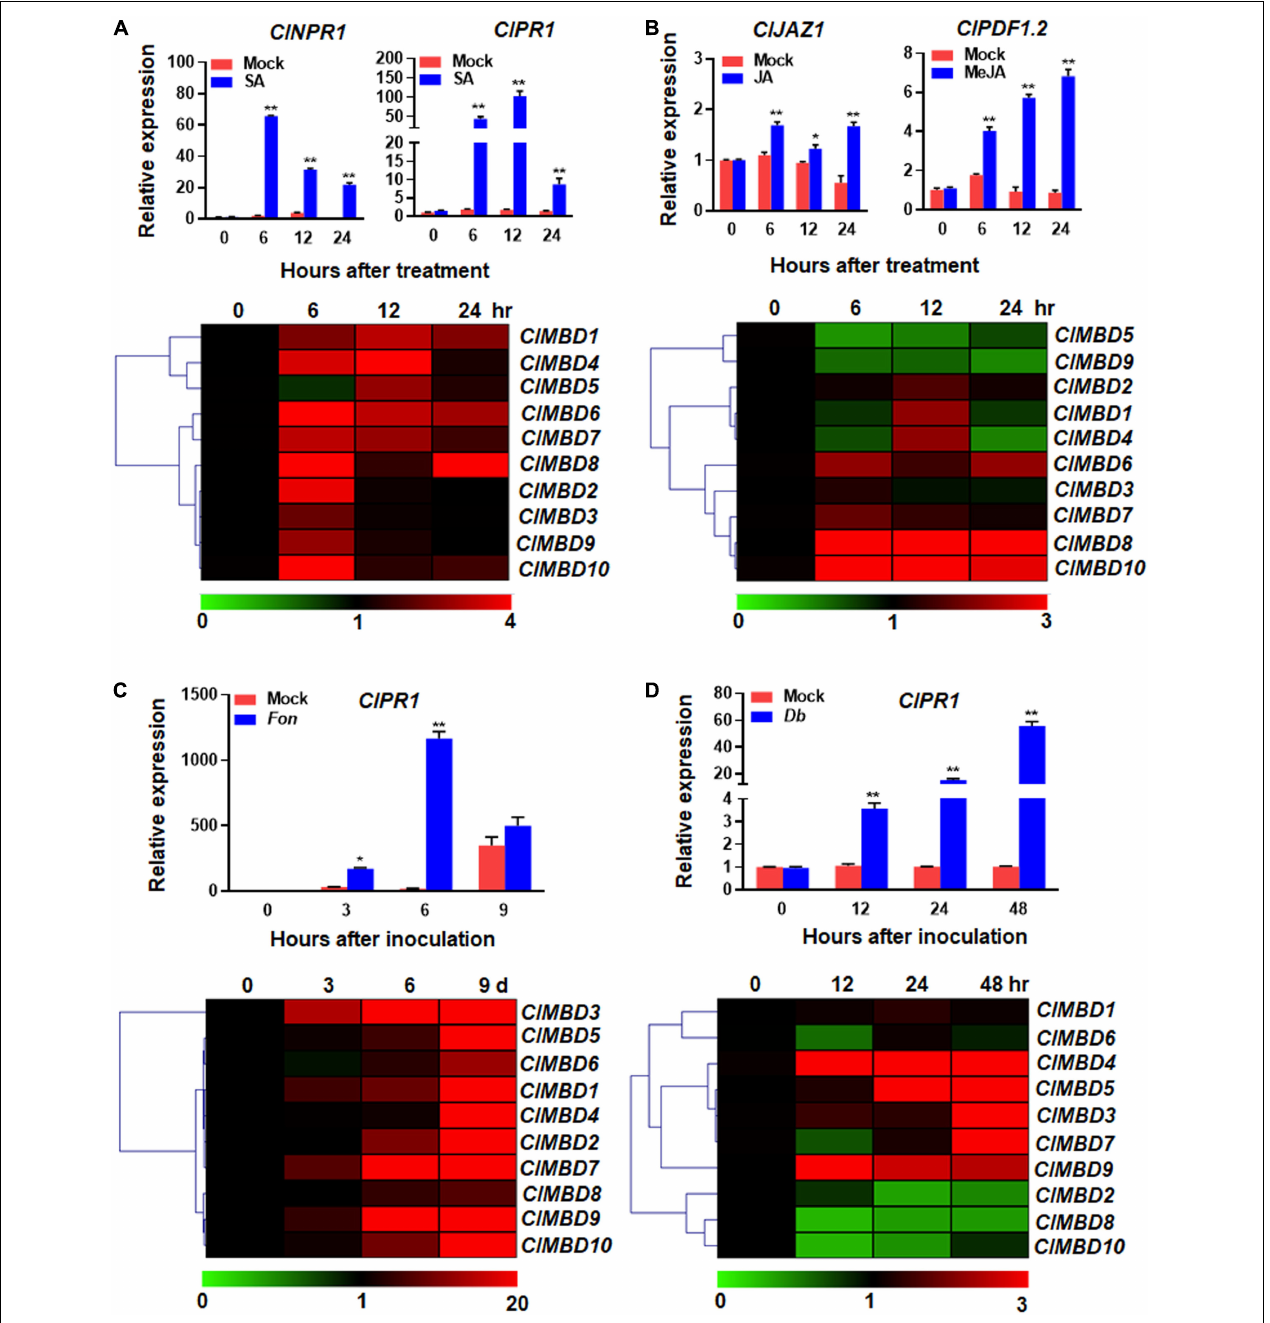
FIGURE 5 | Expression changes of the watermelon ClMBD genes in response to defense hormones and fungal pathogens. (A,B) Expression changes of the ClMBD genes to SA (A) or MeJA (B) . Four-week-old watermelon plants were treated by foliar spraying with 1 mM SA, 100 µ M MeJA or similar volume of solution (as mock controls) and leaf samples were collected at indicated time points after treatment. (C) Expression changes of the ClMBD genes to Fusarium oxysporum f.sp. niveum . Three-week-old plants were inoculated by dipping the roots in spore suspension (1 × 10 7 spores/mL) of F. oxysporum f.sp. niveum or in mung bean liquid broth as mock-inoculated controls, and root samples were collected at indicated time points after inoculation. (D) Expression changes of the ClMBD genes to Didymella bryoniae . Five-week-old watermelon plants were inoculated by foliar spraying with D. bryoniae spore suspension (2 × 10 6 spores/mL) or similar volume of solution as mock controls, and leaf samples were collected at indicated time points after inoculation. qRT-PCR was performed using the watermelon ClGAPDH gene as an internal control. Relative expression was calculated using the 2 − (cid:49)(cid:49) CT method. Experiments were repeated for three times and the data presented are the means ± SE from three independent experiments. * or ** above the columns indicate significant difference at p < 0.05 or p < 0.01 levels (Student’s t -test), respectively, between treatment/inoculation and mock controls at the same time point.